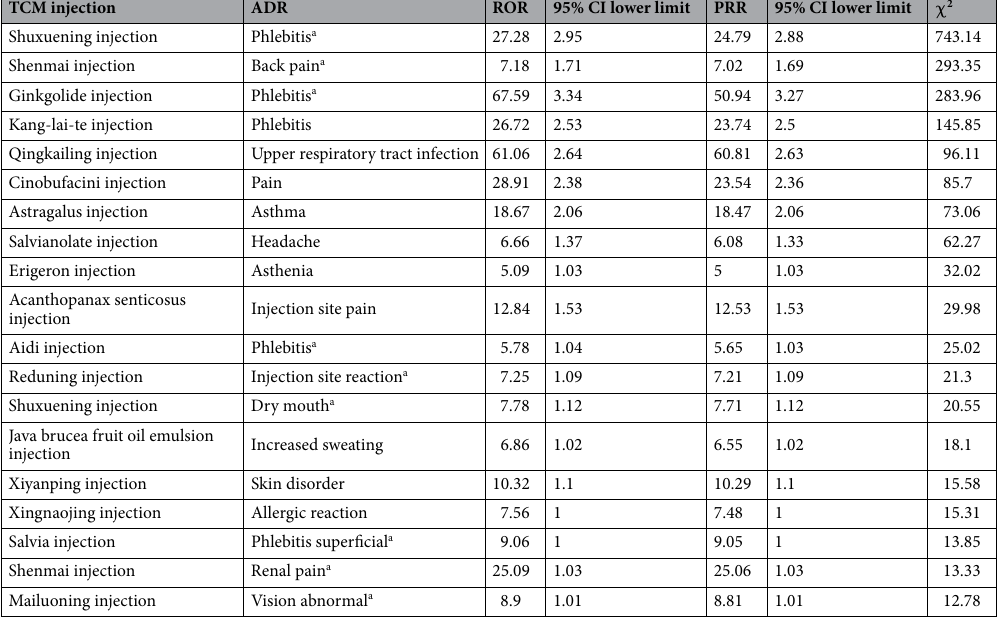
Table 8. The signals of ADRs (3 methods). a Off-label